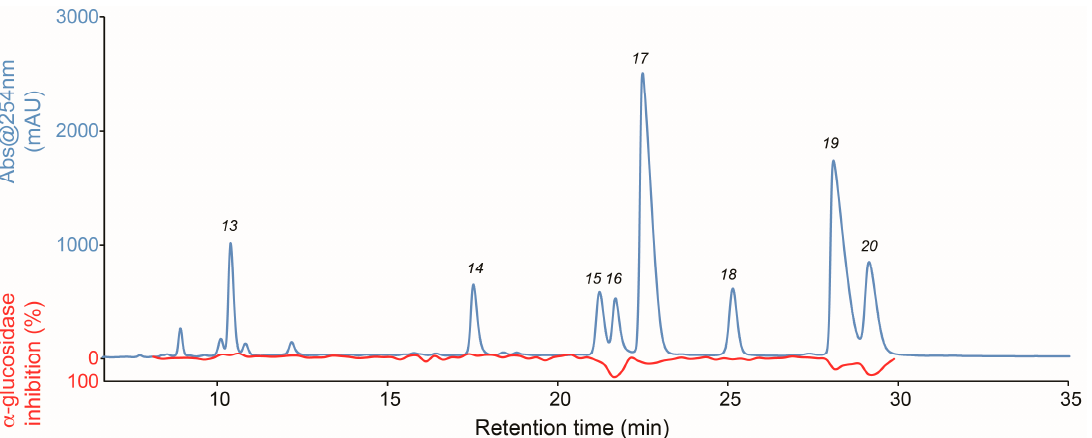
Figure 3. High-resolution α -glucosidase inhibition profile of fraction Fr.2 (red) shown underneath the HPLC chromatogram at 254 nm (blue).